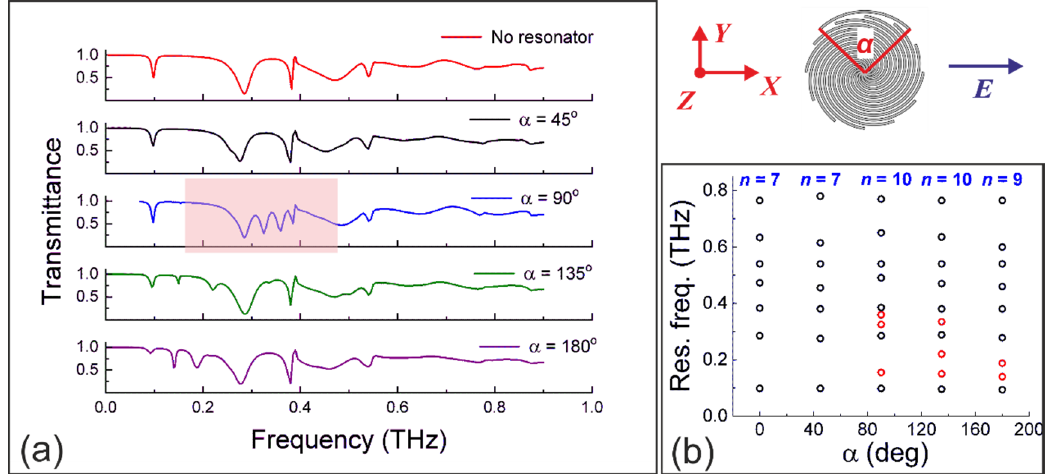
Figure 2. ( a ) Transmittance spectra of the distantly spaced ( p = 768 µm) spiral disks with different C-resonator angles α . Normal incidence ( θ = 0 ◦ ), E || X ; ( b ) The resonance frequencies vs. α ( n —number of resonances), the red circles—the resonances produced by the bright mode of the C-resonator.